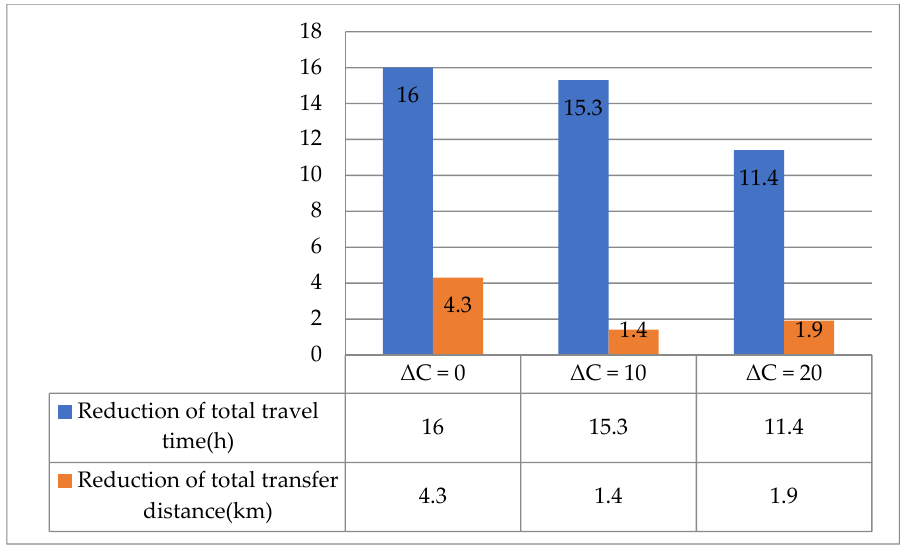
Figure 9. Comparative analysis of the conventional and proposed models for various numbers of routes.